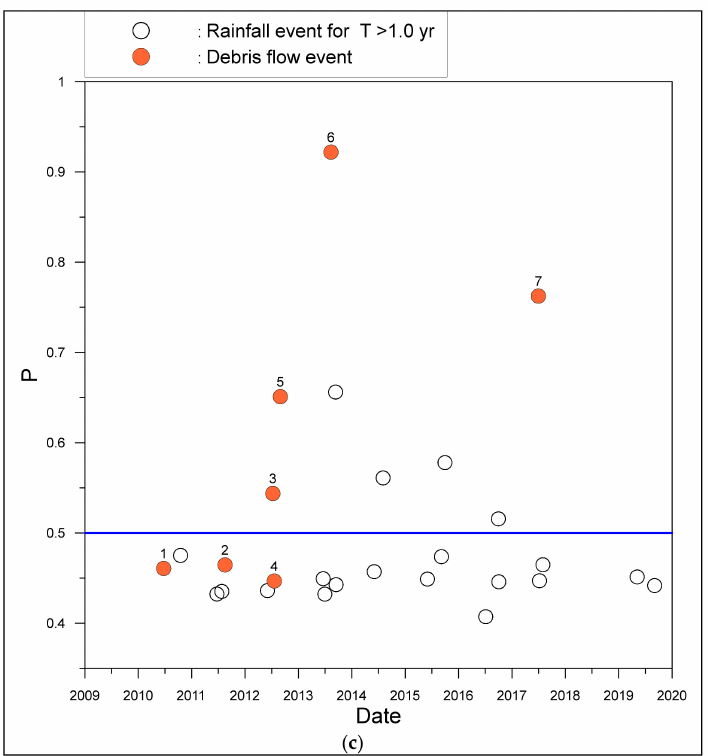
Figure 6. Probability of debris flow occurrence (P) evaluated using the model representing the whole period (WP) and Equation (7) after Typhon Morakot. The rainfall return period (T) in Equation (7) was determined using three rainfall indexes: I m , R d , or RI. ( a ) T determined by I m : six of seven debris flow events were predicted with P ≥ 0.5. Ten rainfall events that did not trigger debris flows were predicted with P ≥ 0.5; ( b ) T determined by R d : four of seven debris flow events were predicted with P ≥ 0.5. Four rainfall events that did not trigger debris flows were predicted with P ≥ 0.5; and ( c ) T determined by RI: four of seven debris flow events were predicted with P ≥ 0.5. Four rainfall events with no triggering of debris flows were predicted with P ≥